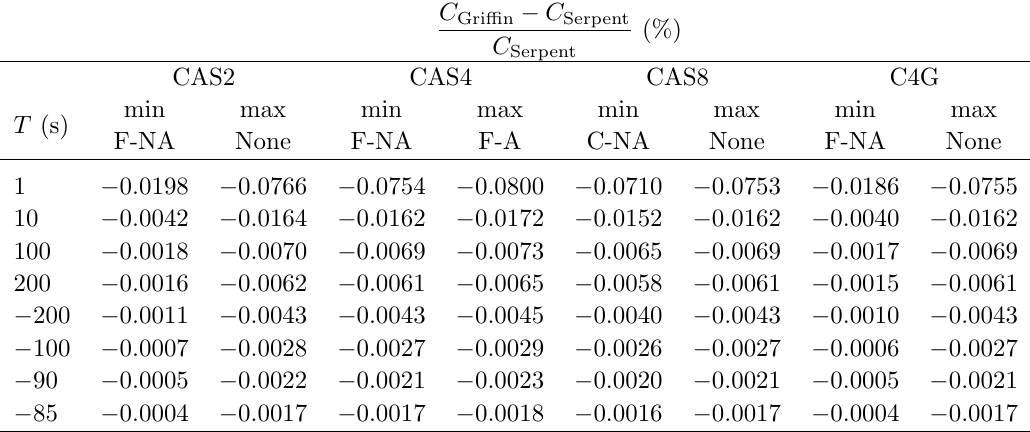
Table 9. Minimum and maximum relative difference cases in Griffin reactivities.